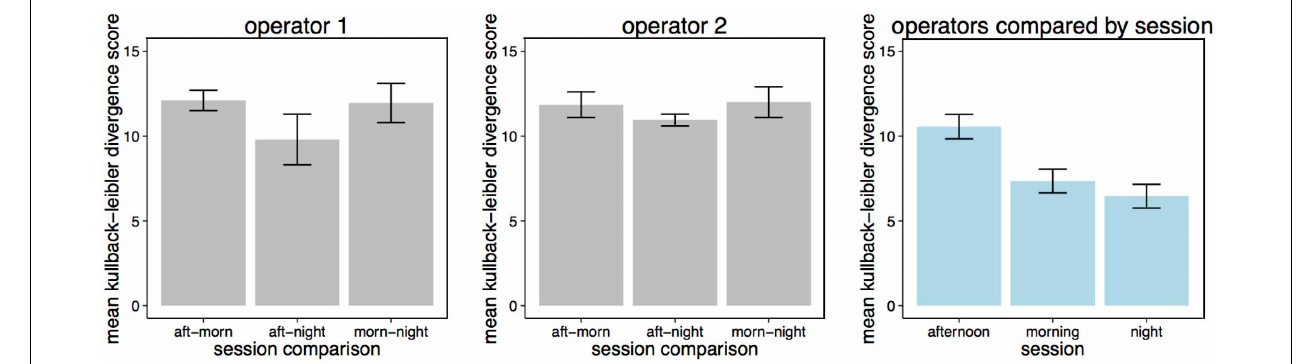
FIGURE 6 | Kullback-Leibler divergence score in screens selected for viewing on the spot monitor by session for Operator 1 (panel 1), Operator 2 (panel 2) and across all sessions (panel 3). ± SE are included,